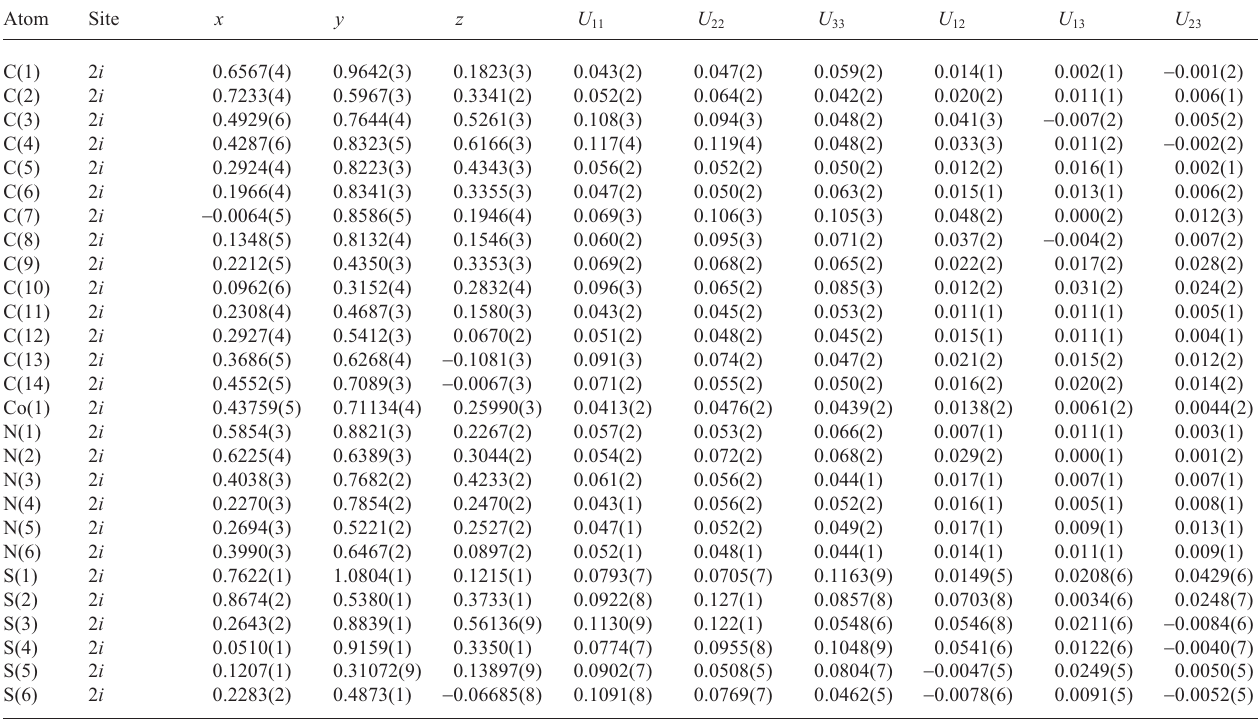
Table 3. Atomic coordinates and displacement parameters (in Å 2 )